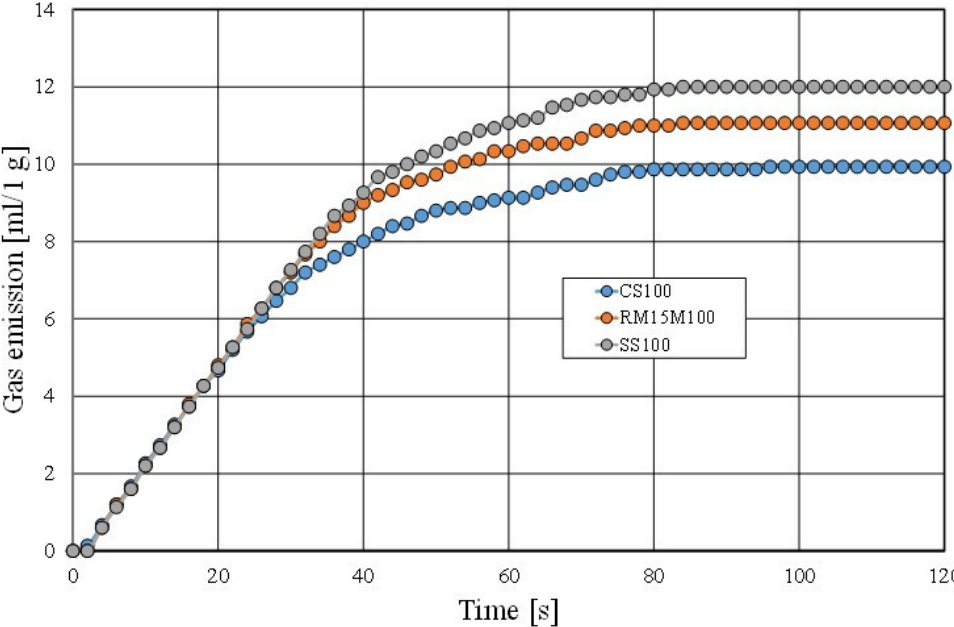
Figure 25. Abrasion S of tested moulding sands.